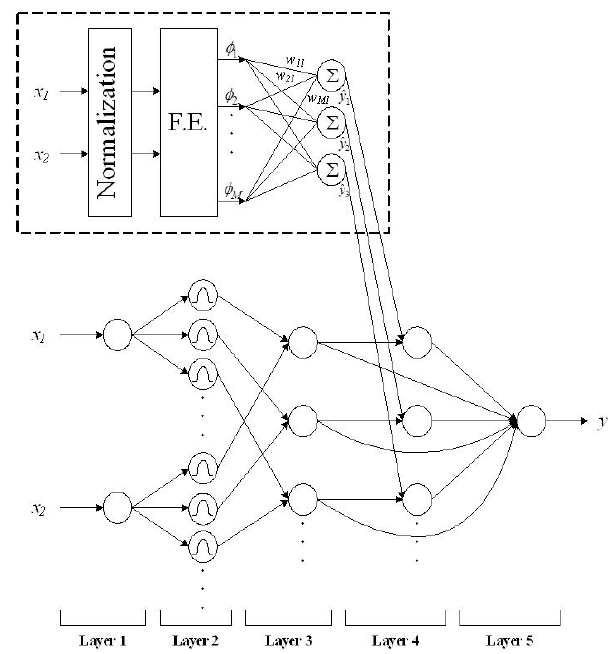
Figure 1. The proposed FNFN architecture.